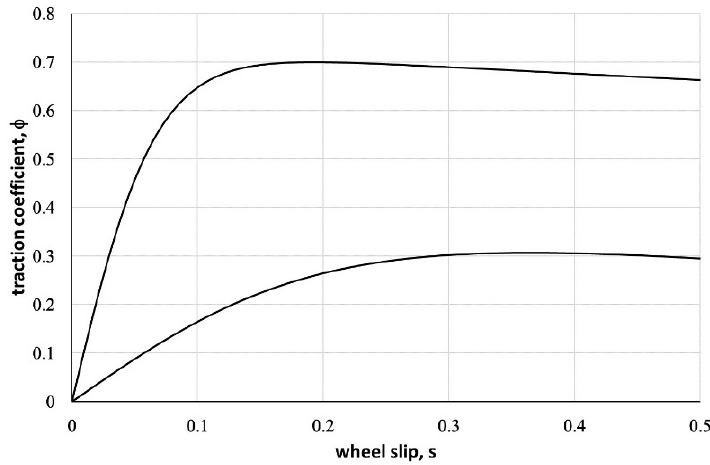
Figure 7. Plot of the traction coefficient of the wheel model as a function of slip.